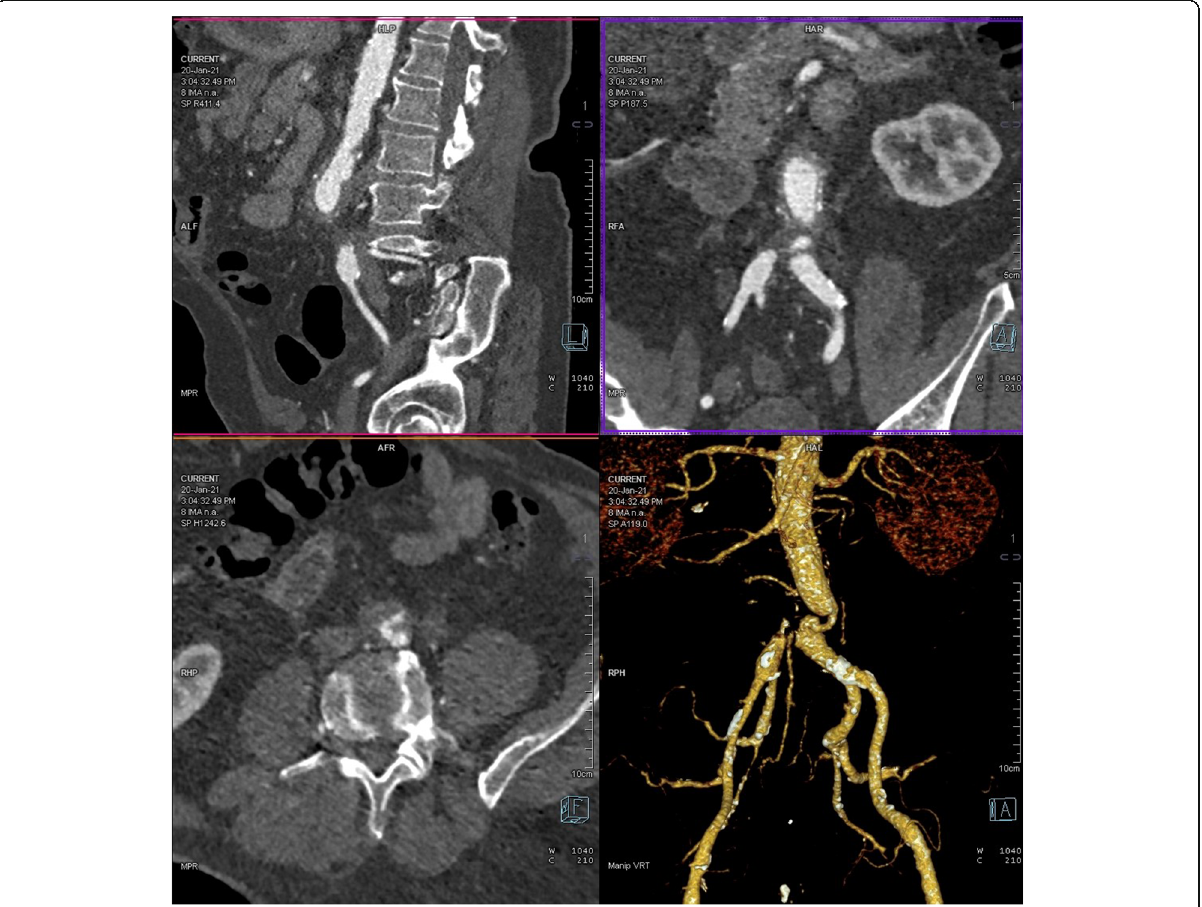
Fig. 1 a CT angiography images performed before the